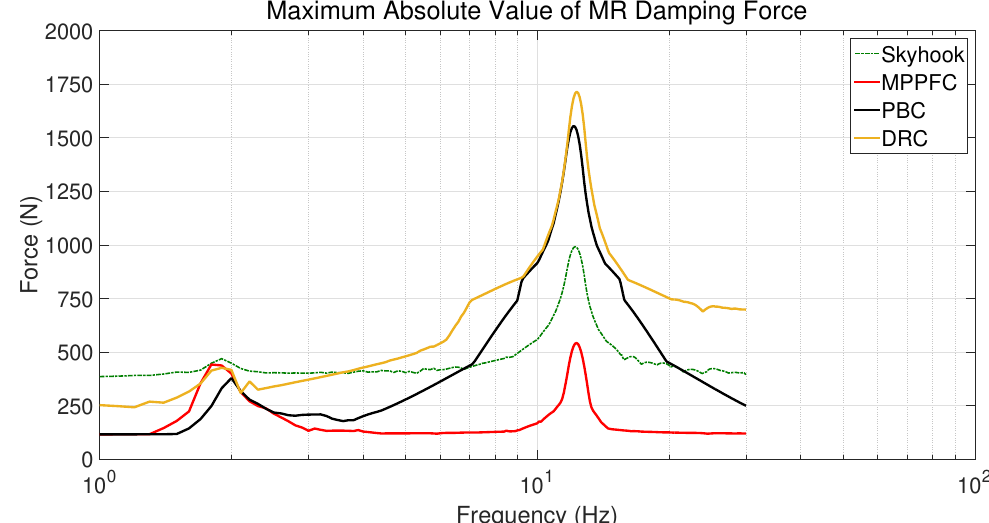
Figure 12. Damping force for the proposed semi-active control (SAC) schemes.